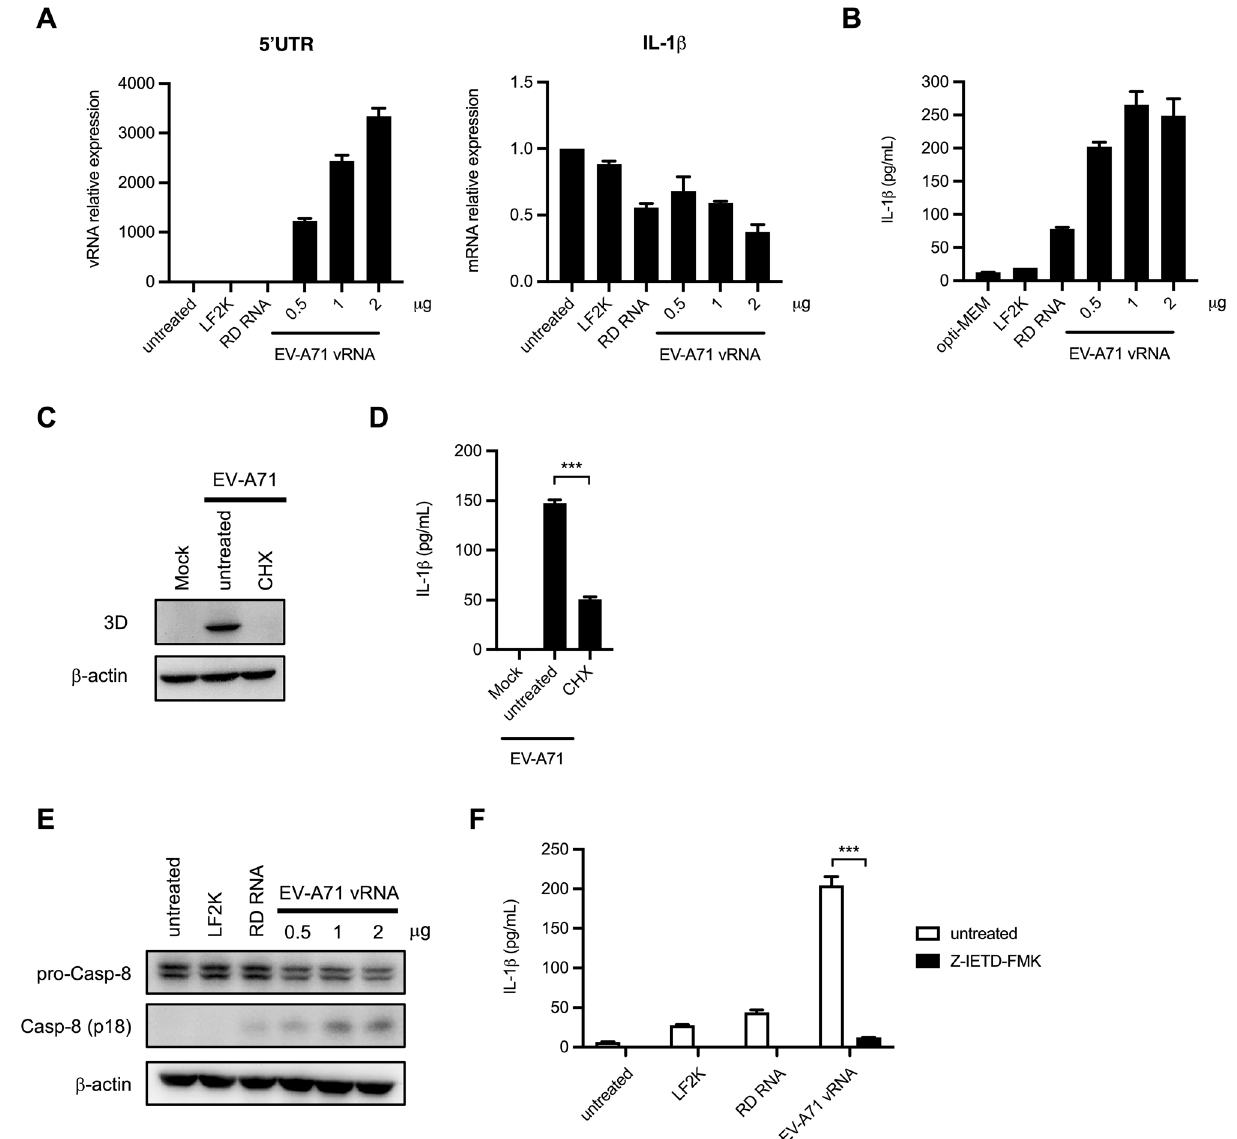
Figure 7. EV-A71 vRNA-triggered IL-1β release is dependent on active caspase-8. ( A ) Different amounts of EV-A71 viral RNA (0.5, 1 and 2 µg) and 1 µg RD cells RNA were transfected into PMA-primed THP-1 cells for 12 h. The expression levels of EV-A71 5’UTR and IL-1β transcripts were examined by RT-qPCR. ( B ) Supernatants were collected and the expression of IL-1β was analyzed by ELISA. ( C ) PMA-primed THP-1 cells were treated with cycloheximide (CHX) (100 μM) for 12 h to suppress the de novo protein synthesis. The untreated and CHX-treated THP-1 macrophages were infected with EV-A71 for 12 h. The expression of EV-A71 3D protein and β-actin was examined by Western blot. ( D ) The released IL-1β levels were determined by ELISA. ( E ) THP-1 macrophages were transfected with 1 µg RD cellular RNA or EV-A71 vRNA (0.5, 1, and 2 µg). The expression of pro-caspase-8, cleaved caspase-8, and β-actin was examined by immunoblot. ( F ) THP-1 macrophages were stimulated by 1 µg RD RNA or EV-A71 vRNA. Then the cells were treated with Z-IETD- FMK for 12 h. The supernatants were harvested and subjected to IL-1β ELISA. (*** p < 0.001, Student’s unpaired